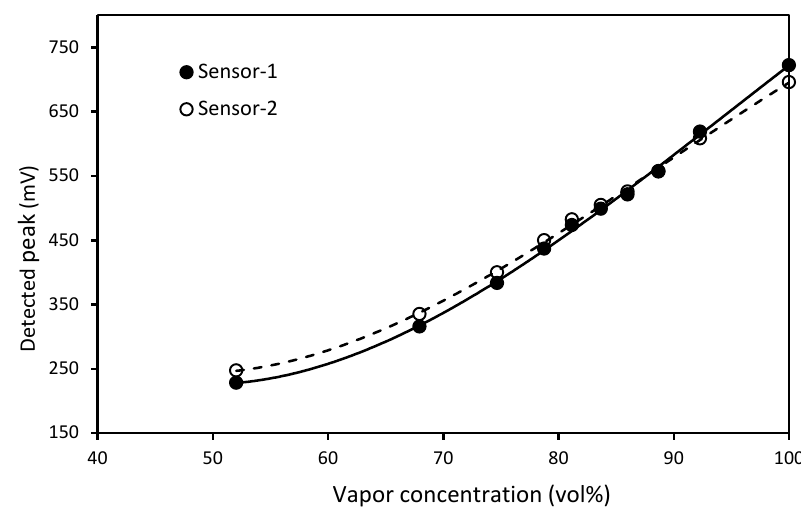
Figure 4. Gas sensors calibration curves.